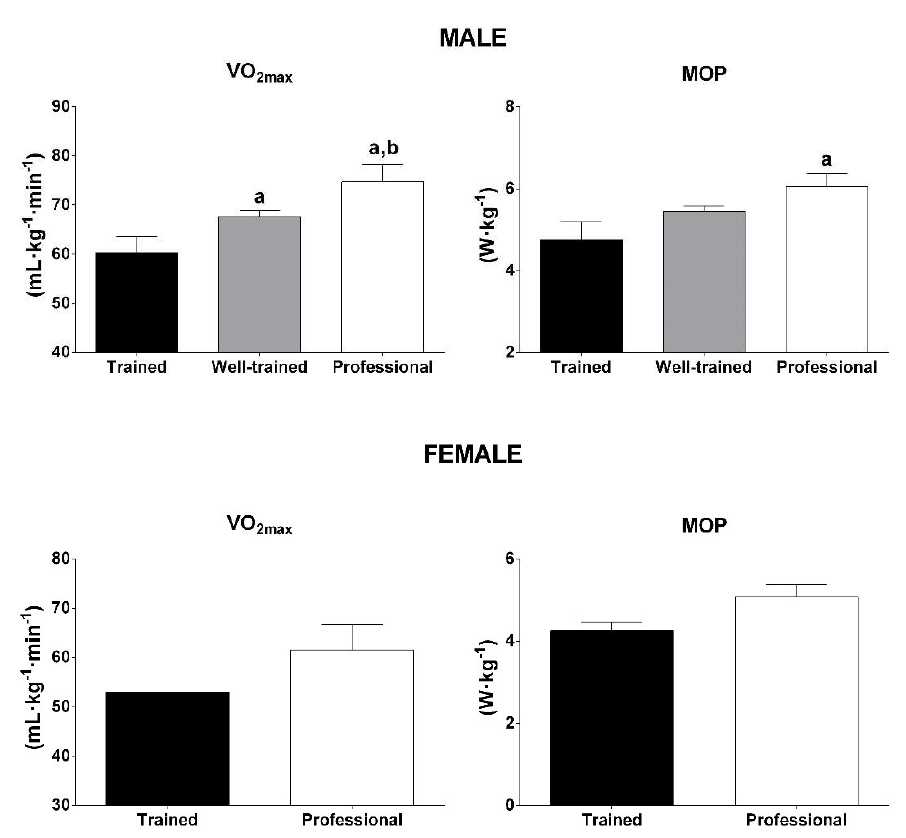
Figure 6. Physiological profile of the cyclists according to performance level and sex. Data are mean ± SD or only mean. One-way ANOVA test for VO 2Max and Kruskal–Wallis test for MOP presented p value: p < 0.01; a <0.01 vs. trained; b <0.01 vs. well-trained. VO 2Max : maximal oxygen uptake; MOP: maximal oxidative power.